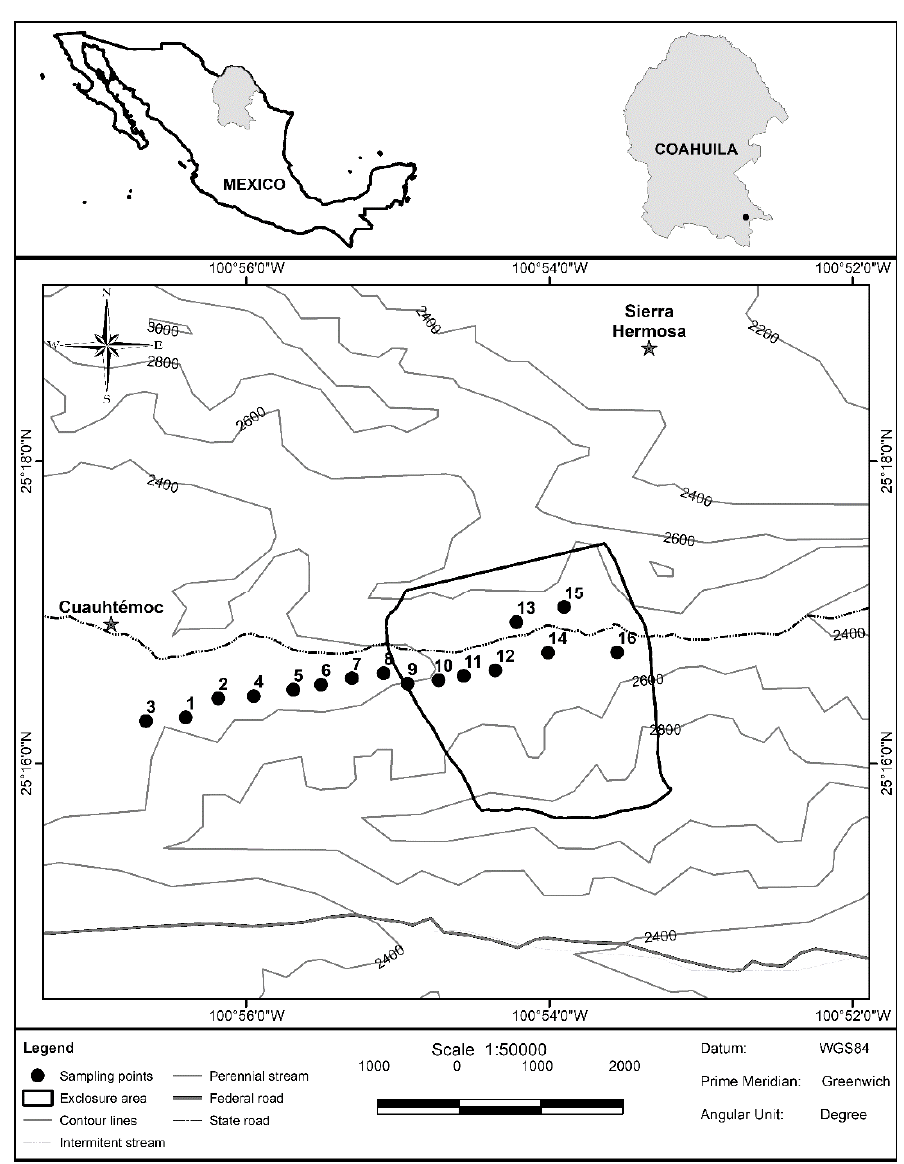
Figure 1. Location of the Protected Natural Area Sierra of Zapalinamé in northern Mexico (25° N). The grazing-excluded area is indicated (surrounded by a grey line), as well as the location of the plots.